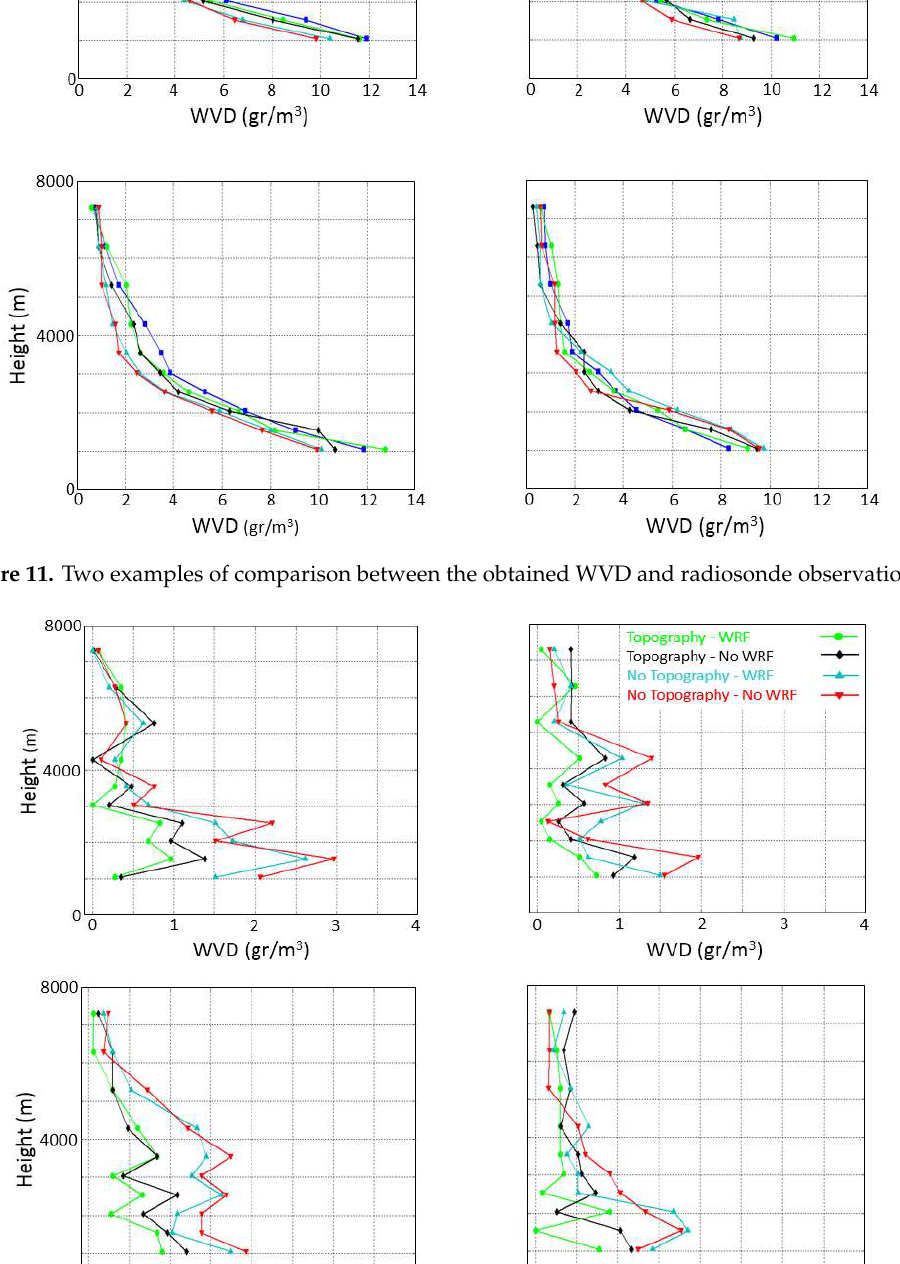
Figure 12. Two examples of the absolute value of the di ff erence between the radiosonde observations and the obtained results .